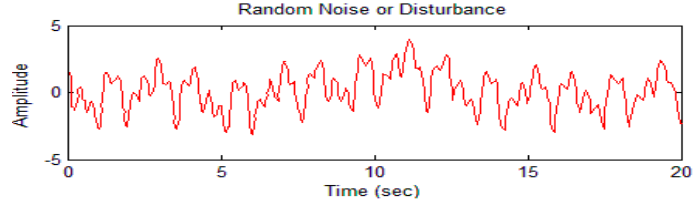
Figure 11. External noise or disturbance is added to the system dynamics.